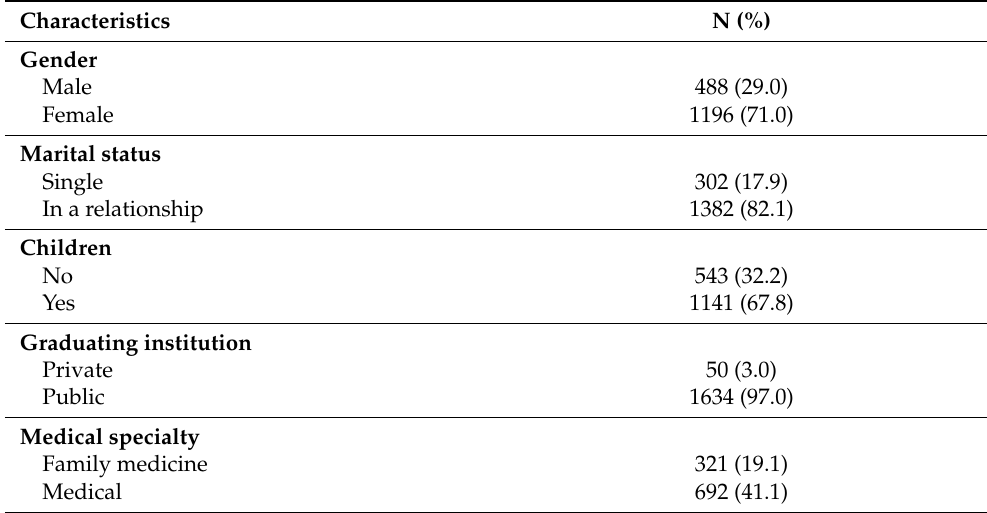
Table 1. Socio-demographic and professional characteristics of the participants * ,1